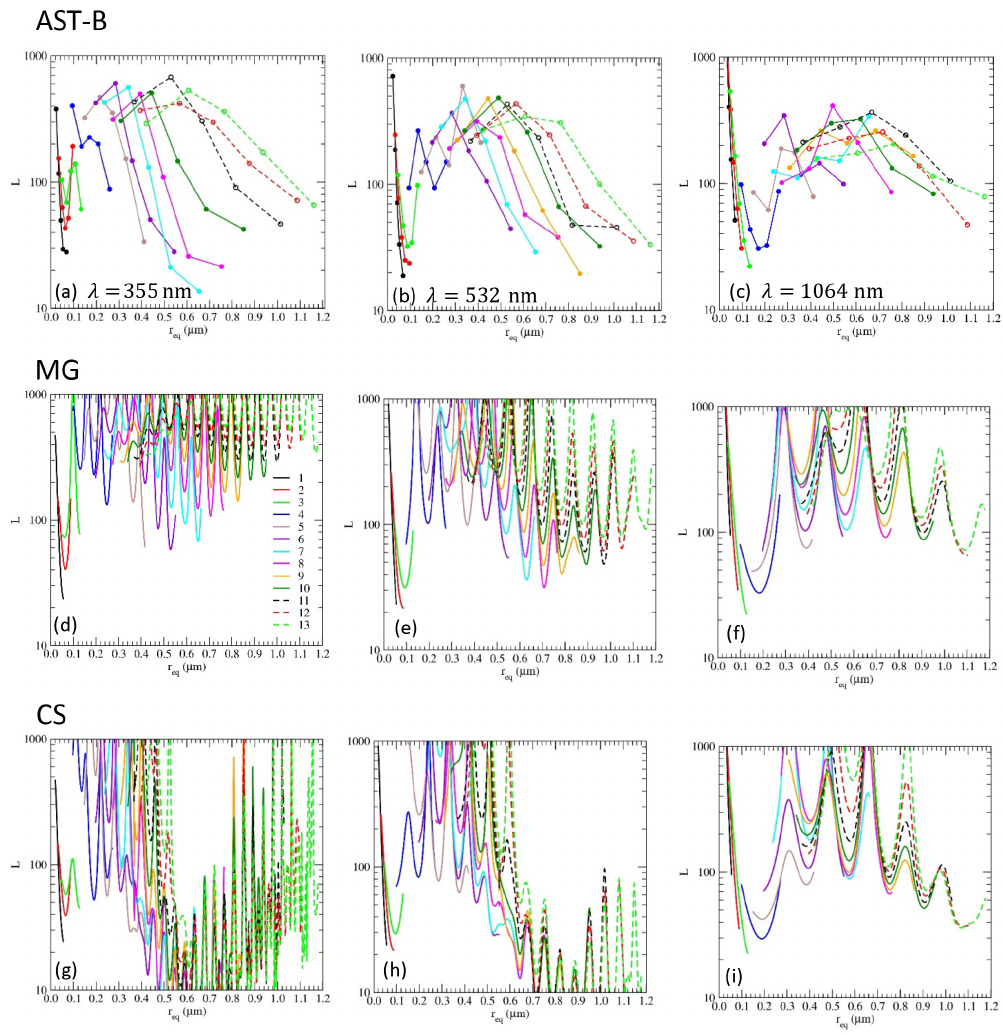
Figure 9. As Fig. 8, but for internally mixed Type B particles (AST-B) (a–c) , MG (d–f) and CS (g–i) . The horizontal scale differs from that shown in Fig.